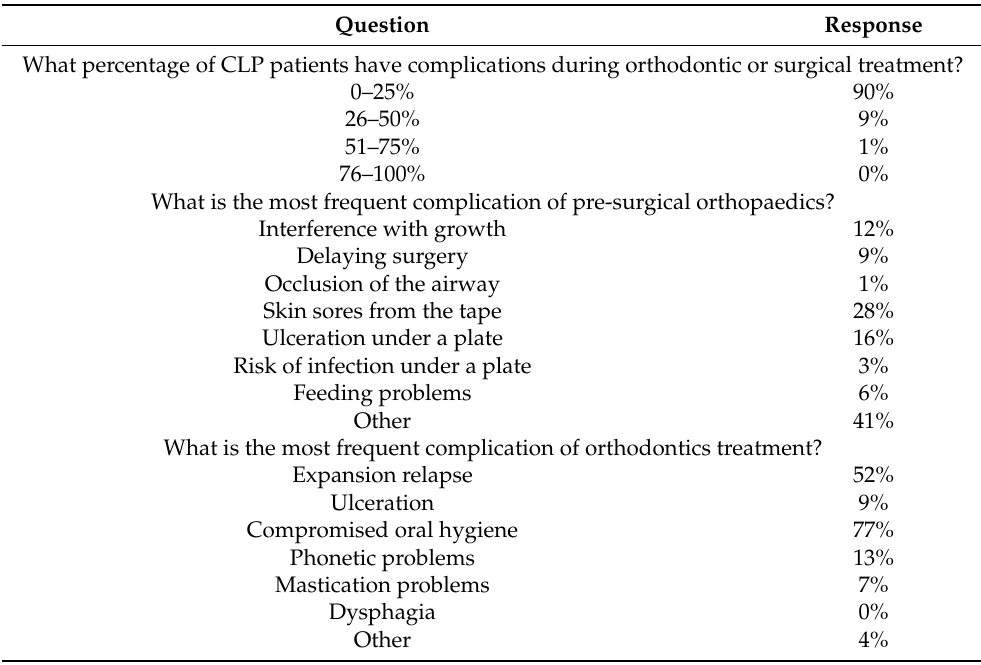
Figure 2. Distribution of patient population by type of orthodontic treatment. Orthodontic procedures were reported to have few complications, with compromised oral hygiene (77%) being the most reported (Table 3). Regarding pre-surgical orthopaedics, complications were mainly skin sores from the tape (28%). Table 3. Complications of orthodontic procedures.